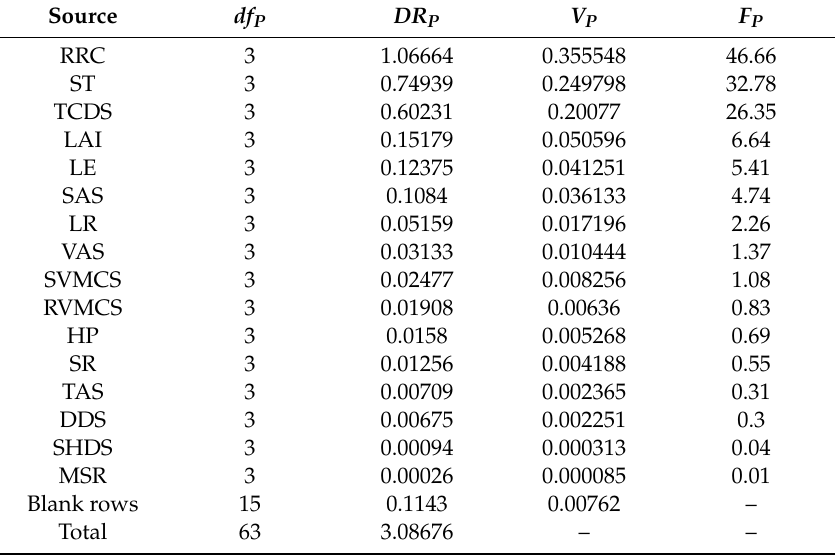
Table 10. ANOVA of the green roof factors and the cooling load savings